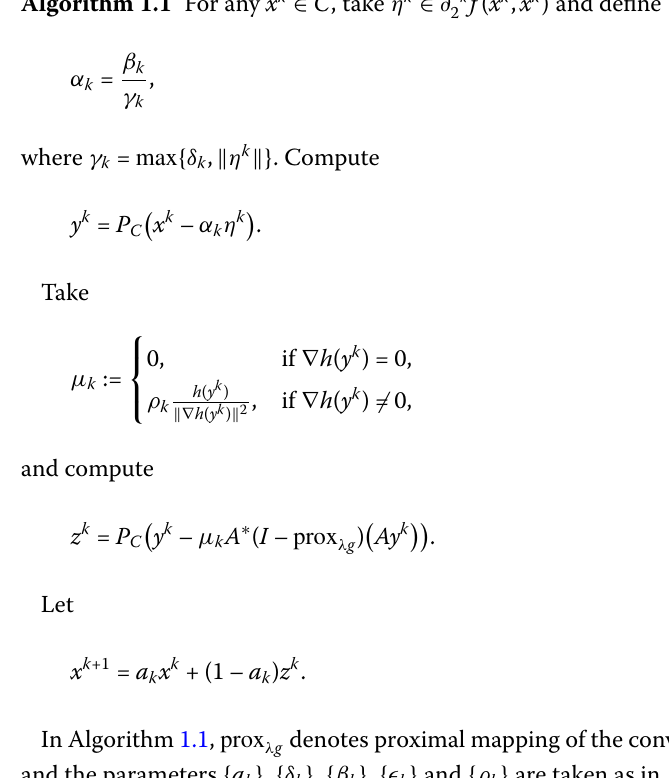
Algorithm 1.1 For any x k ∈ C , take η k ∈ ∂ (cid:4) k